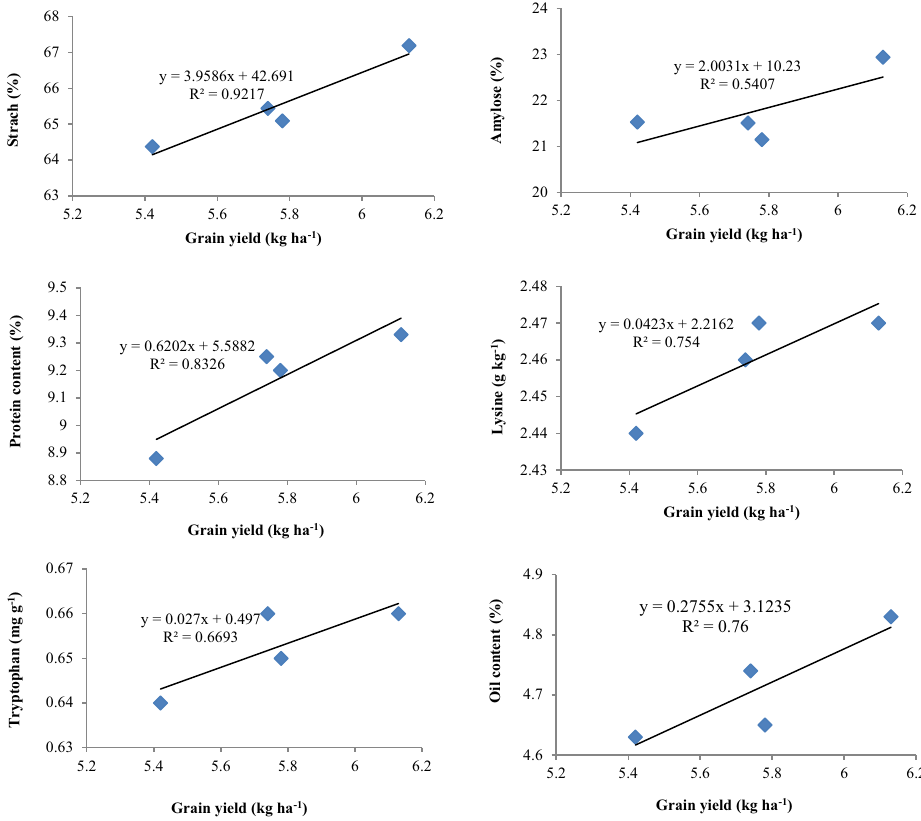
Figure 5. Correlation between grain yield and quality parameters of maize under CETM practices in maize under